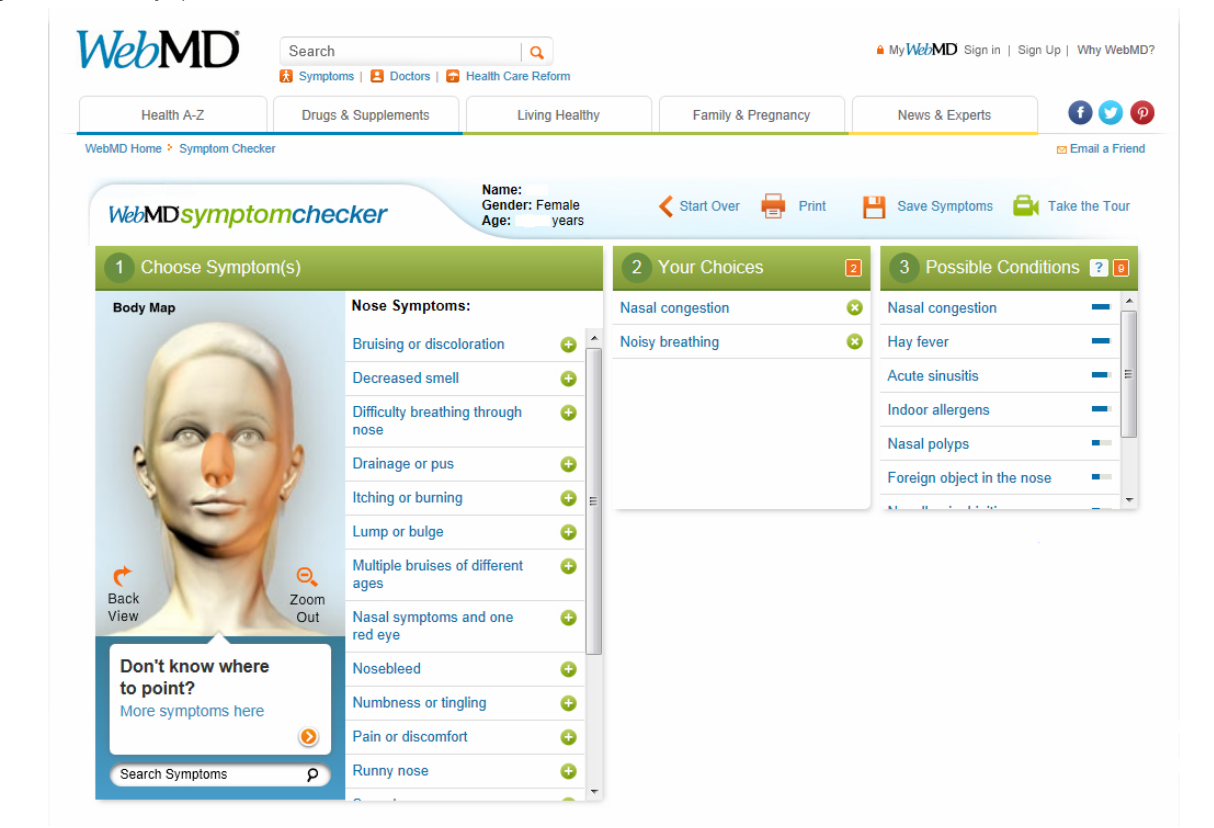
Figure 1. WebMD symptom